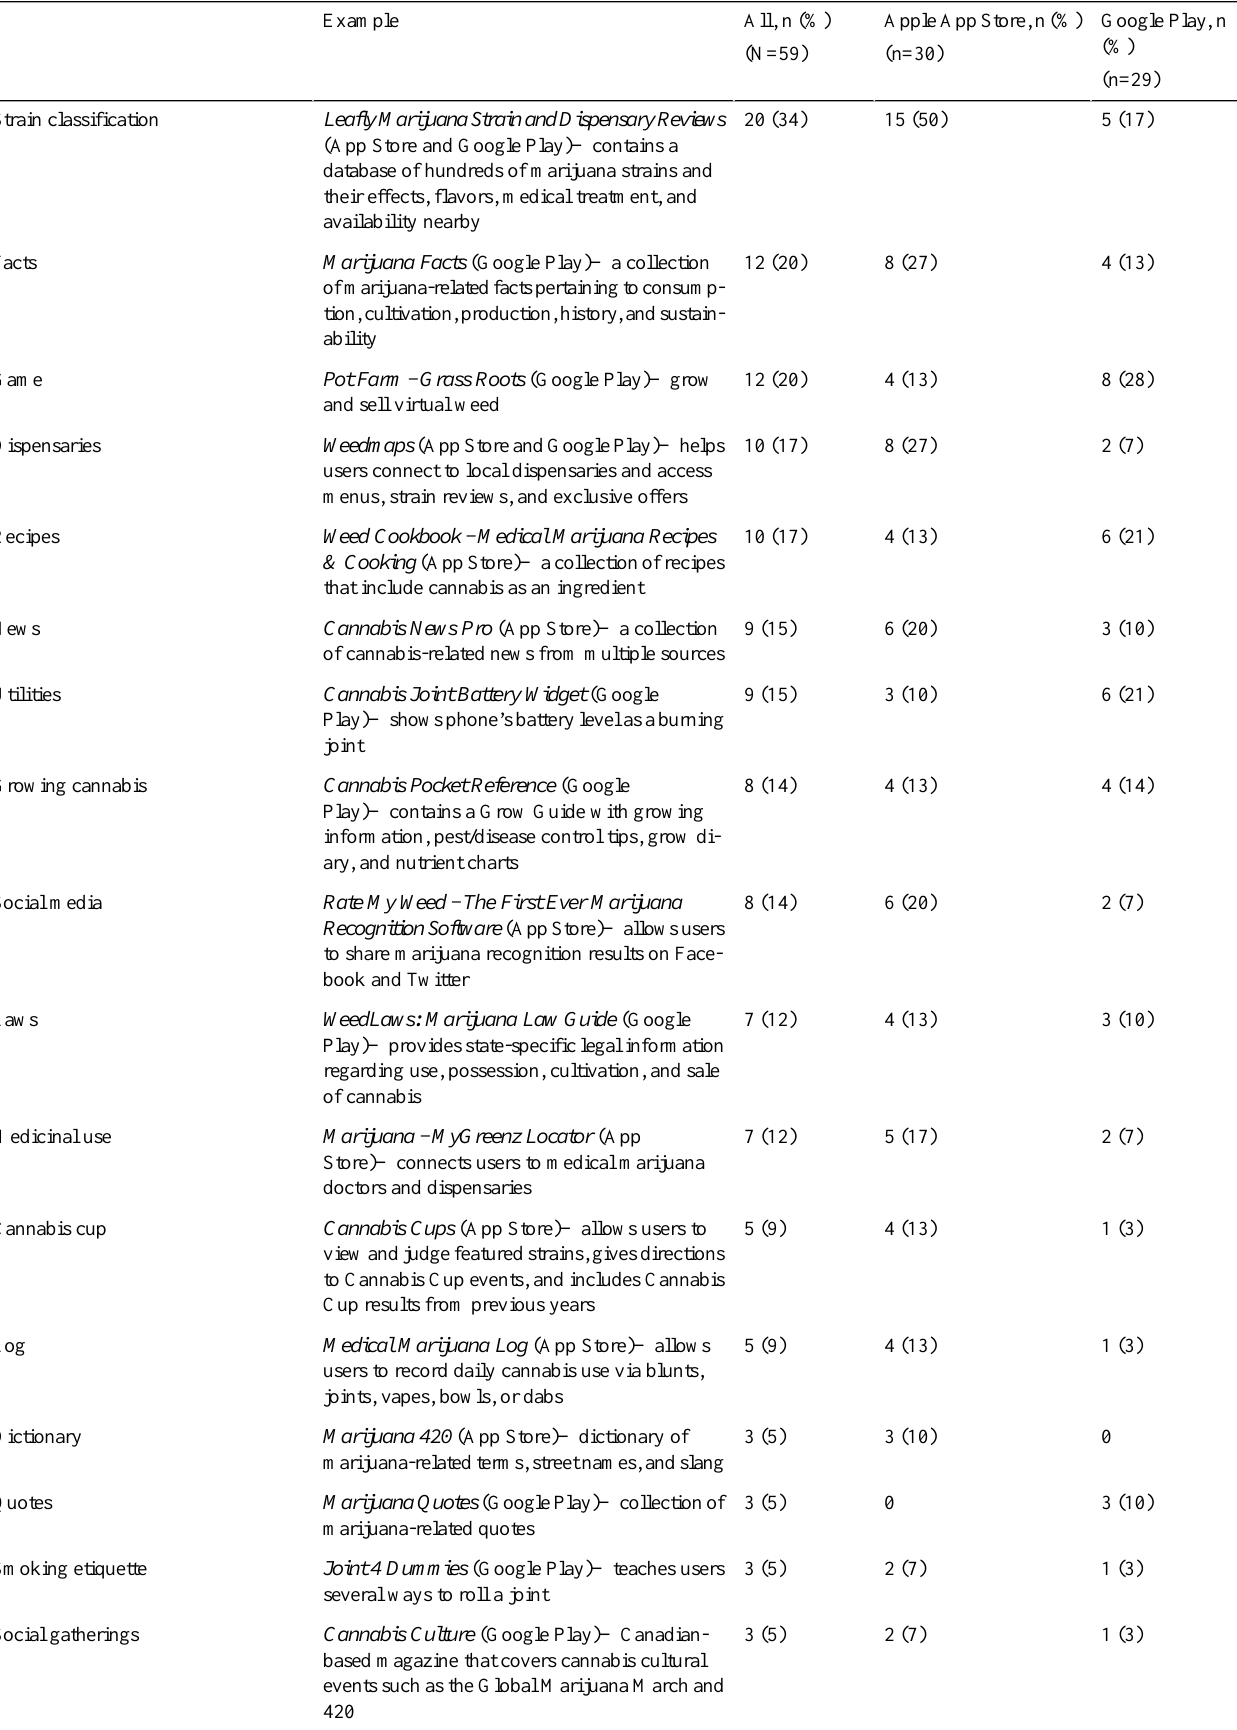
Table 2. Content codes of mobile cannabis apps (N=59).